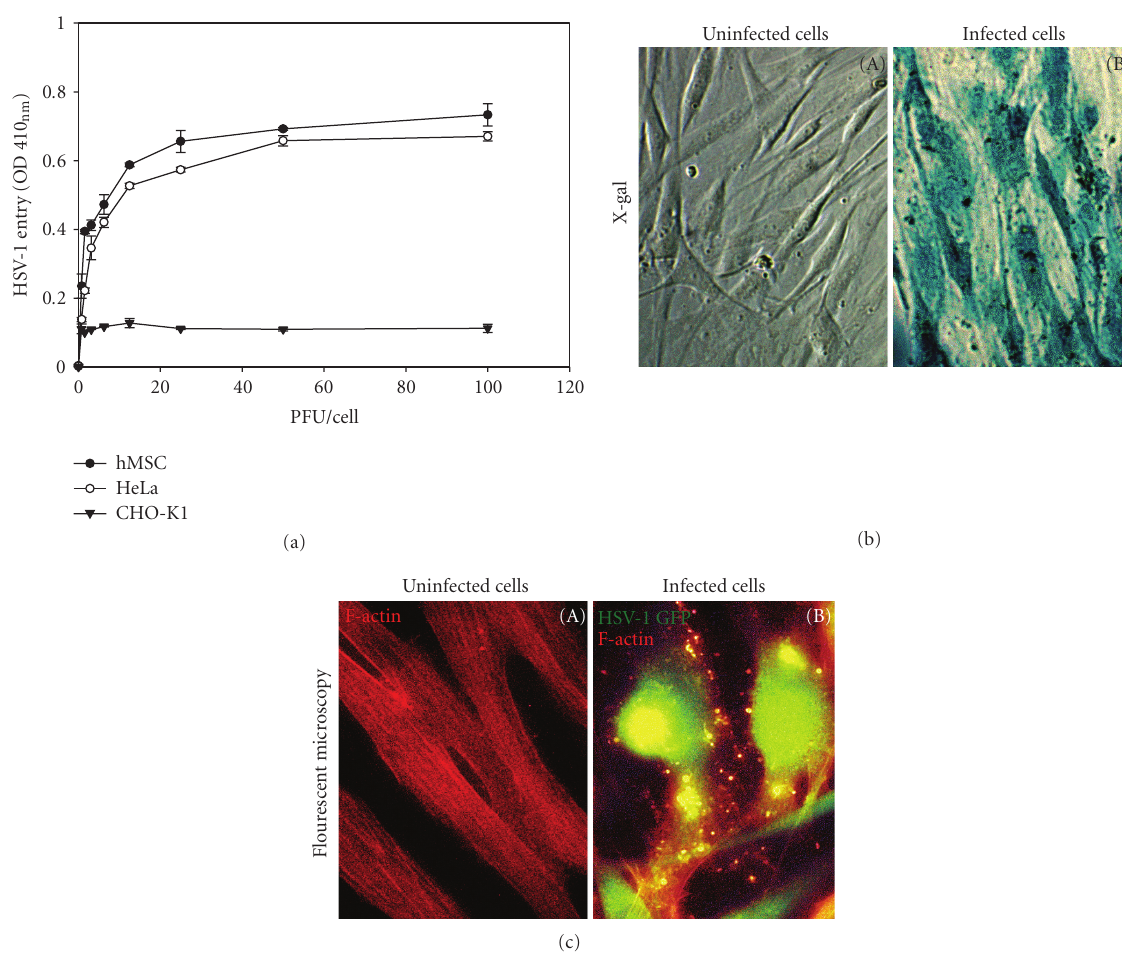
Figure 1: Herpes simplex virus type-1 (HSV-1) entry into cultured human mesenchymal stem cells (hMSCs). (a) Dosage response analysis of HSV-1 entry into hMSCs. Recombinant HSV-1(KOS) gL86 enters hMSCs and naturally susceptible HeLa cells but not wild-type CHO-K1 cells in a dosage-dependent manner. Data represent the mean ± the standard deviation of results from triplicate wells in a representative experiment. (b) β -galactosidase staining of HSV-1 entry. Cultured hMSCs that were exposed to HSV-1(KOS) gL86 (panel (B)) were 100% stained blue, indicating 100% viral infection, whereas uninfected cells did not show any staining. (c) Fluorescence imaging of HSV-1 entry. Confluent monolayer culture of hMSCs were mock infected (panel (A)) or infected with GFP-tagged HSV-1 (K26-GFP) at 50PFU/cell (panel (B)) and stained with TRITC-conjugated phalloidin (red color), which binds to F-actin. HSV-1 infected cells showed both green fluorescence from HSV-1 capsid and red fluorescence from F-actin expression (green and red overlapping areas appear yellow), whereas mock-treated cells only showed red fluorescence. The images were taken on fluorescent microscope at 20x